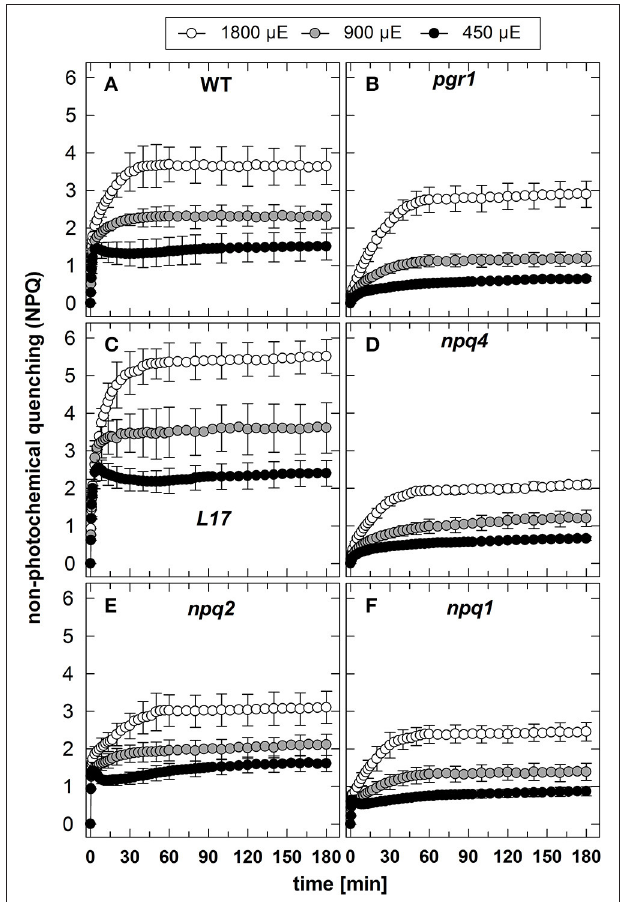
FIGURE 1 | NPQ induction. The induction of NPQ during 180min of illumination at three different actinic light intensities (450, 900, and 1,800 µ E of white light) was determined for (A) WT, (B) pgr1 , (C) L17 , (D) npq4 , (E) , npq2, and (F) npq1 plants. During the whole measurements, detached leaves were placed on wet paper in a temperature-controlled cuvette (20 ◦ C) under permanent supply with ambient air. Mean values ± SE of 3–6 independent measurements are shown.